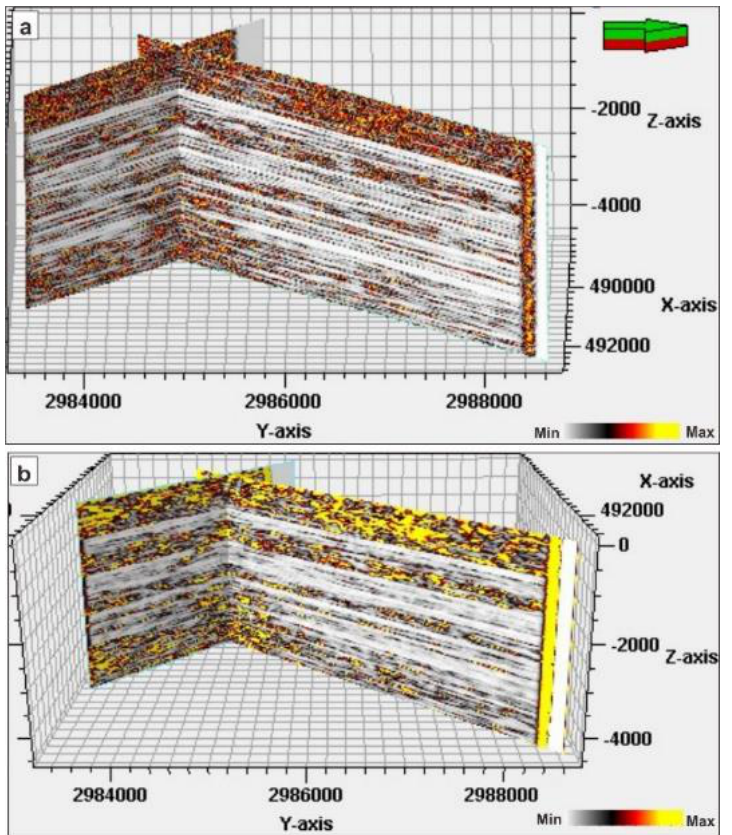
Figure 14. ( a ) Chaos attribute pre-processed volume; ( b ) variance attribute pre-processed volume.